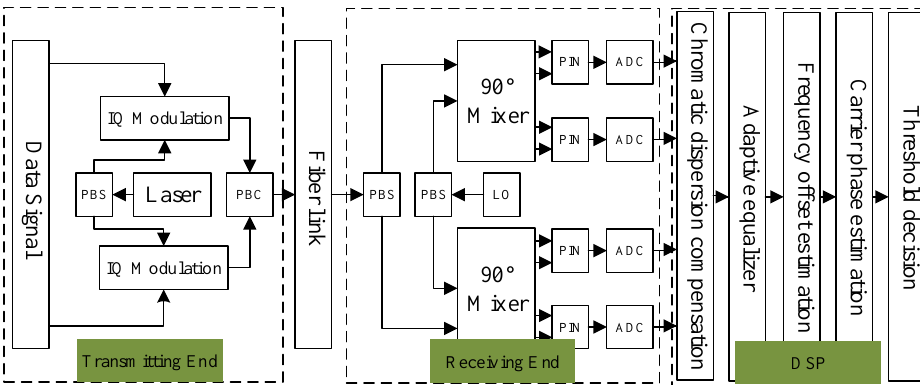
Figure 4. Coherent optical communication system structure diagram.